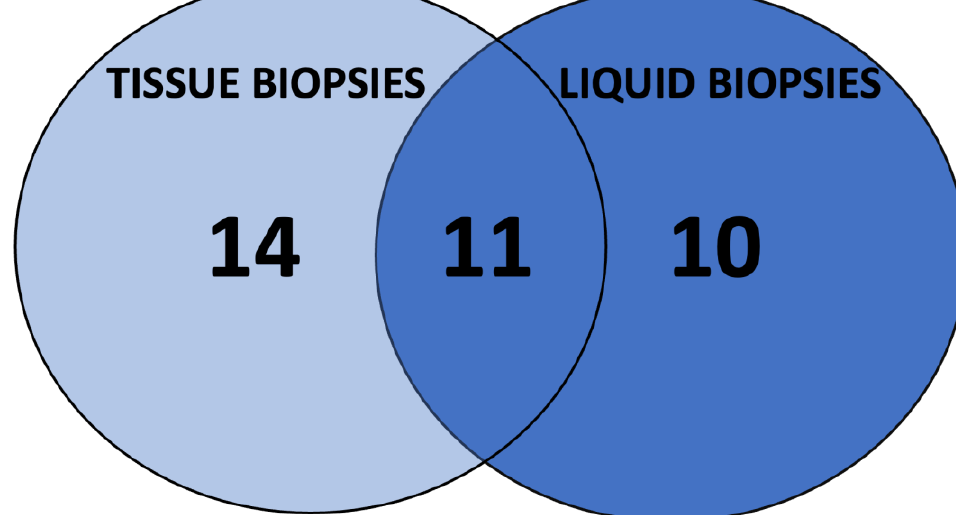
Figure 3. Venn Diagram showing molecular alterations found on LB and tissue biopsy.